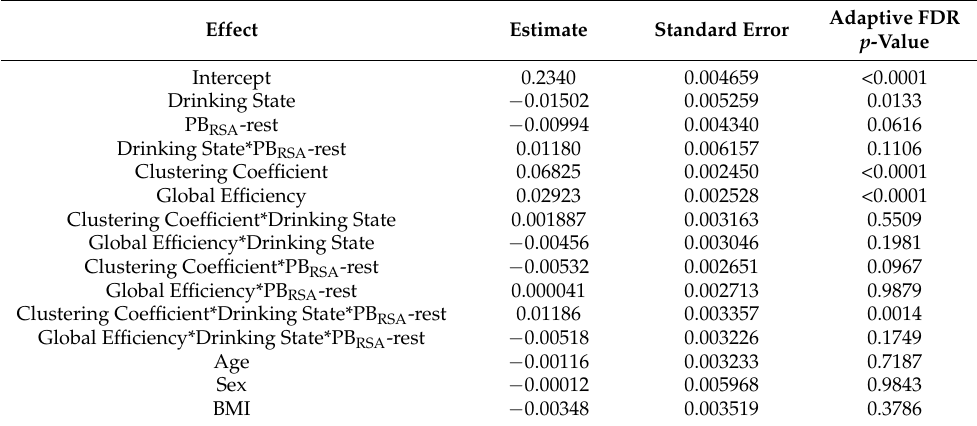
Table 2. Relevant mixed-model strength results. Full model results are available in the Supplemen- tary